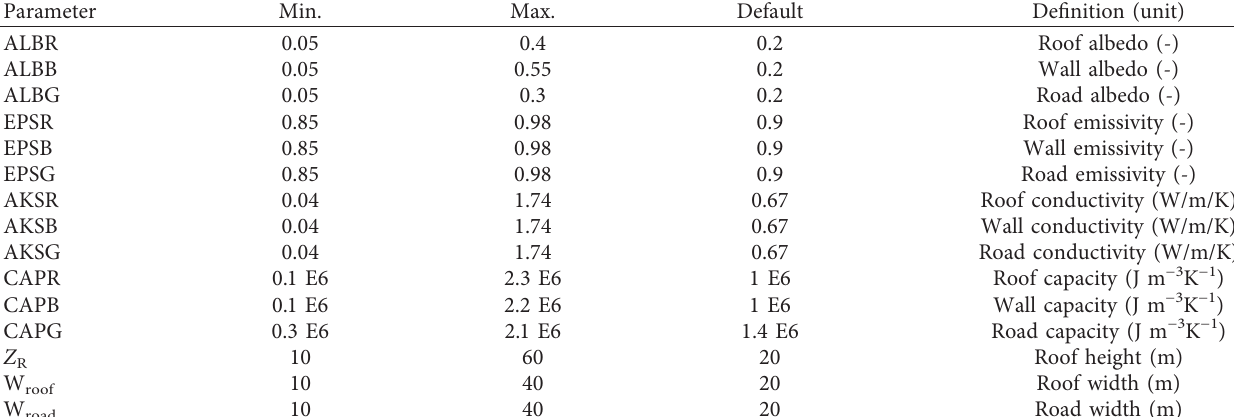
Table 1: SLUCM input parameters selected for analysis, value space, and default values. Min. Max.